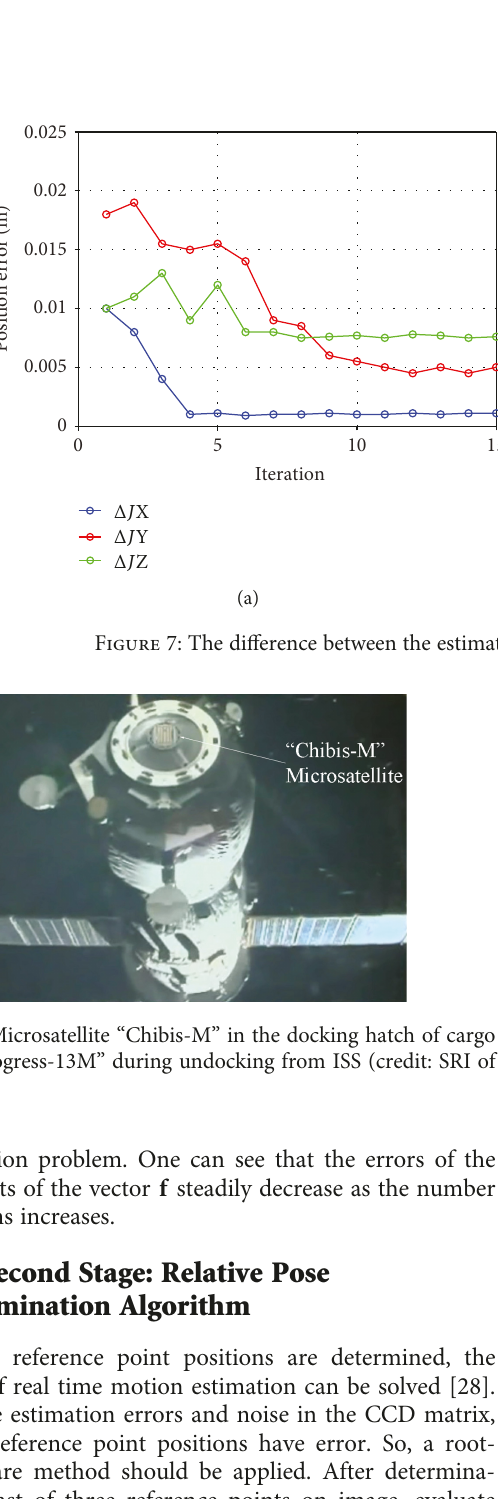
Figure 8: Microsatellite “ Chibis-M ” in the docking hatch of cargo vehicle “ Progress-13M ” during undocking from ISS (credit: SRI of